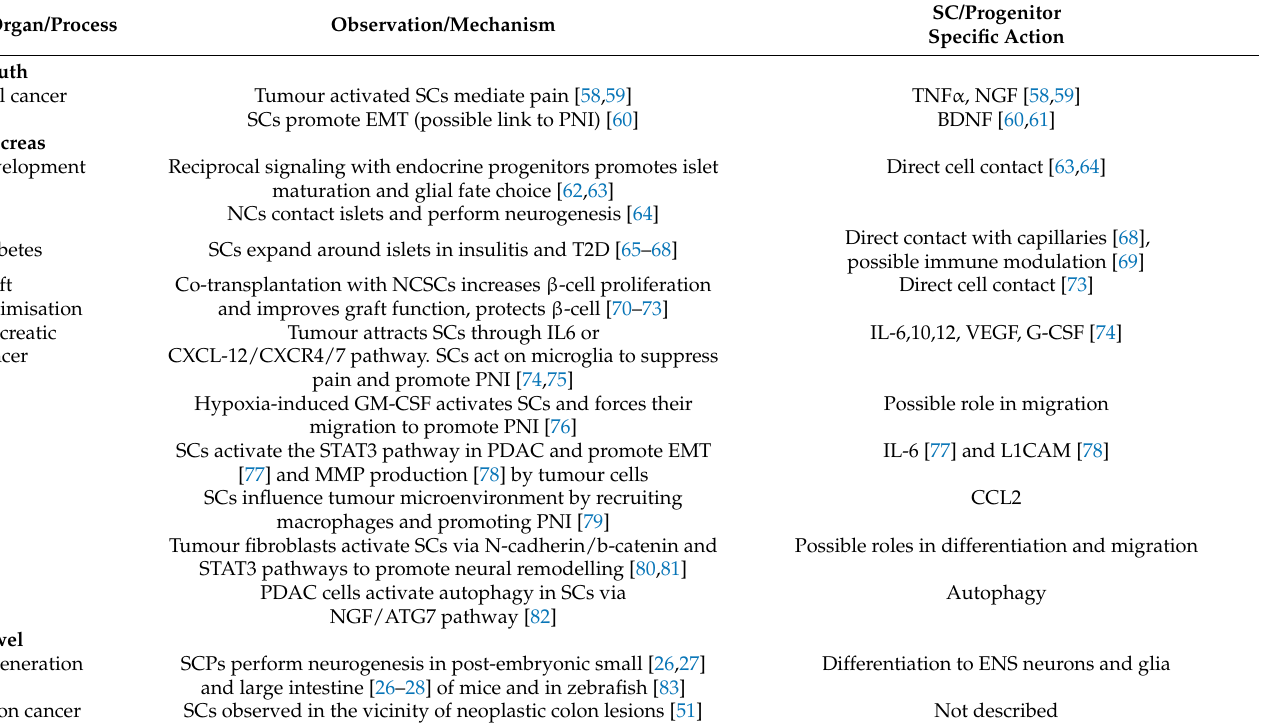
Table 1. Functions of Schwann cells (SCs) and SC progenitors in the organs of the digestive